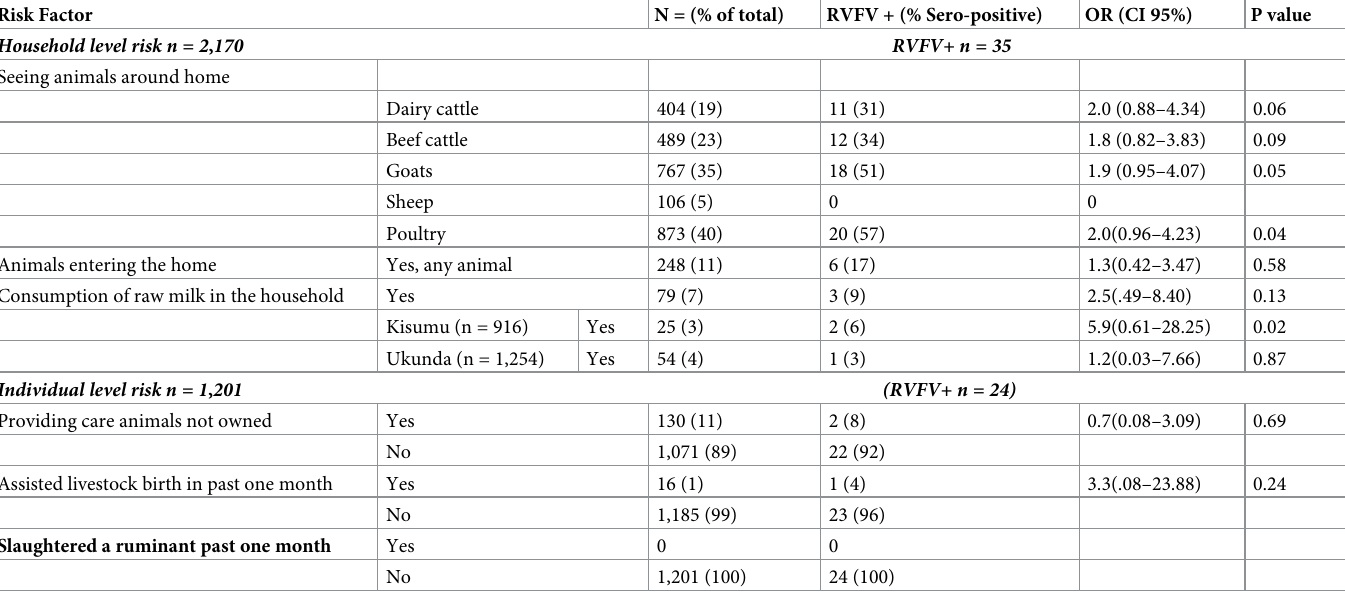
Table 2. Animal contact bivariate analysis for Rift Valley fever virus exposure.